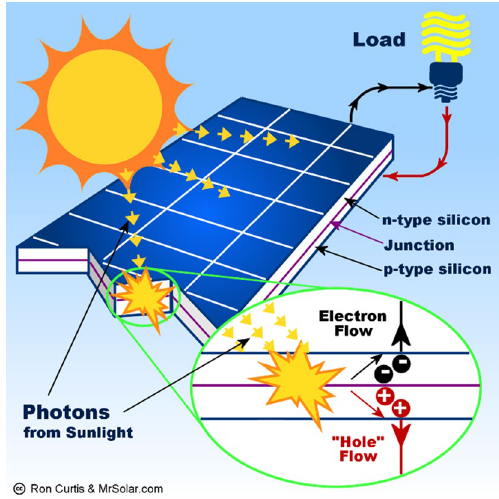
Fig. 9 Power conversion mechanism for solar PV